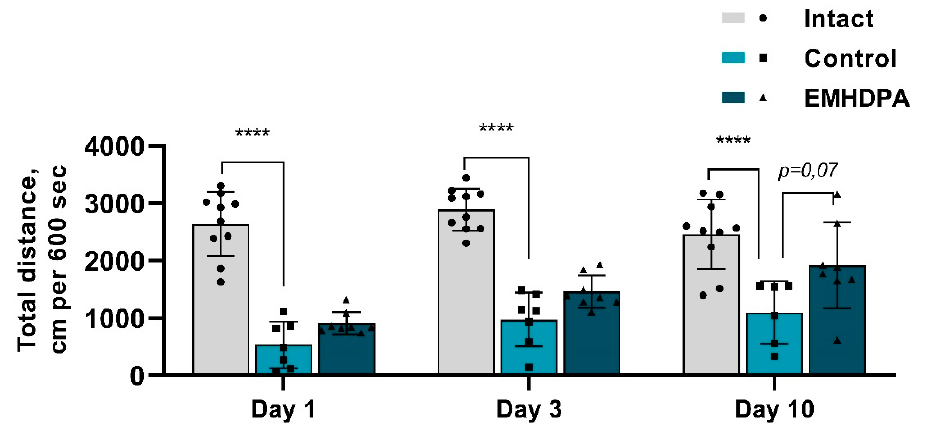
Figure 8. The effect of the studied drugs on the total distance in the actimetry test. Note: ****— p < 0.0001; 1—intact group; 2—control group; 3—group administered with EMHDPA 25 mg/kg.